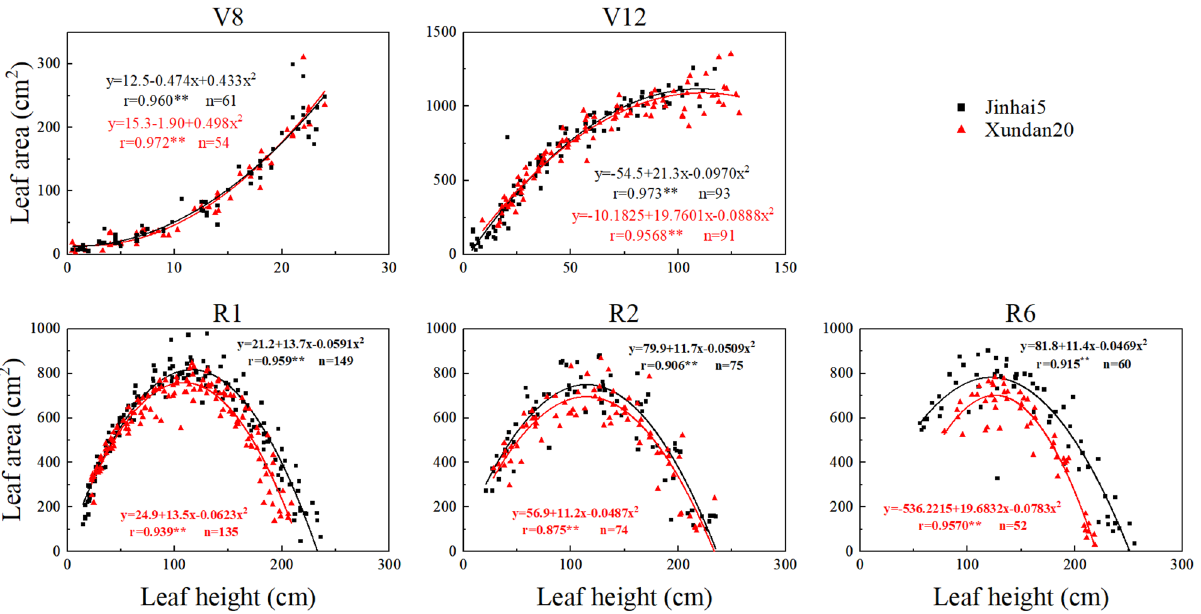
Figure 6. The vertical leaf area distribution during whole growth period for 2 tested cultivars of maize. **Statistically significant at 0.01 probability